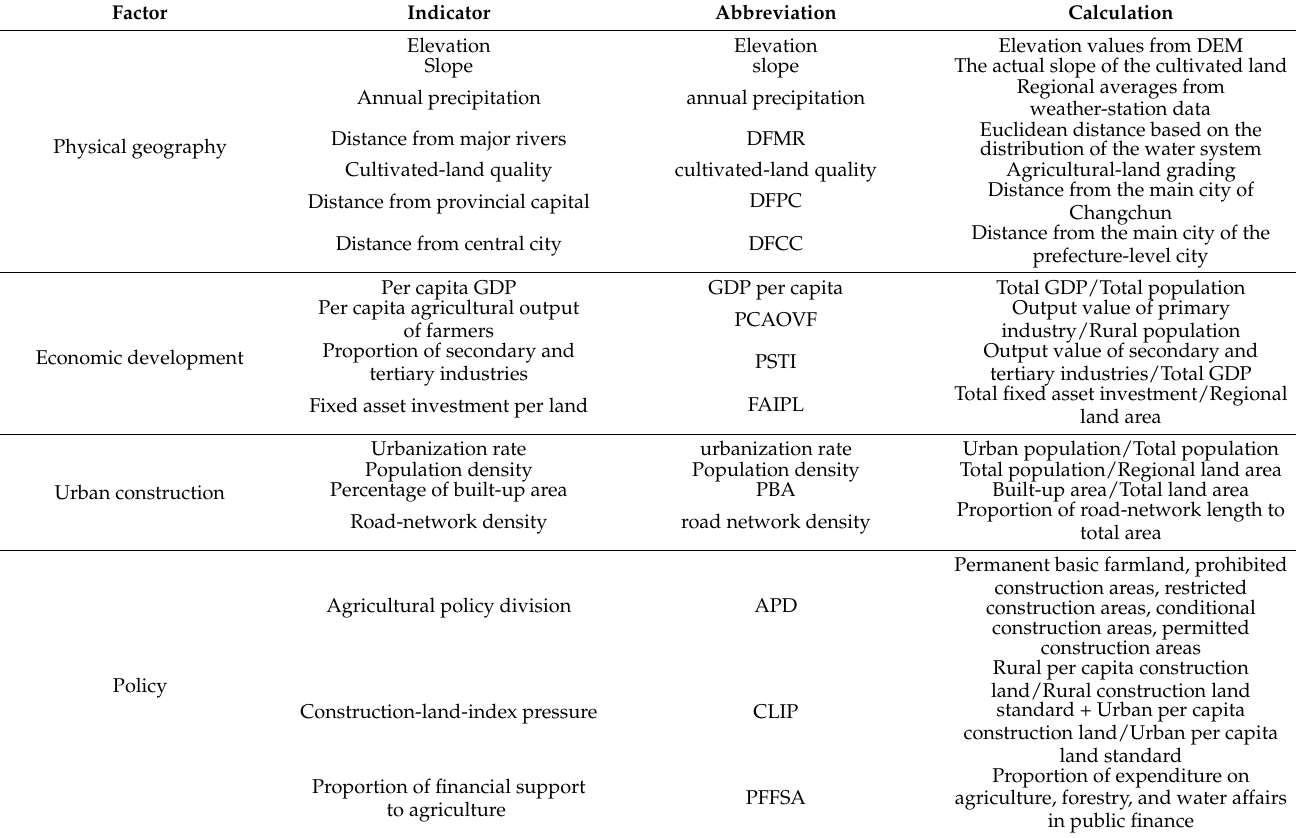
Table 3. Definition of factors influencing the multi-functionality of cultivated land. The per capita construction-land standard in rural areas was 150 m 2 /person, and the urban per capita construction- land standard was 120 m 2 /person. The average weighting method was used to measure the overall pressure; the management and control levels of permanent basic farmland, prohibited construction areas, restricted construction areas, conditional construction areas, and permitted construction areas in the agricultural-policy zoning decreased in order, and were assigned values of 5, 4, 3, 2, and 1, respectively, in the calculations. Because of data limitations in 1990 and 2000, Jilin Province did not produced agricultural-land-grading data; the average grain yield was used to correct the cultivated-land utilization to obtain graded data for the corresponding